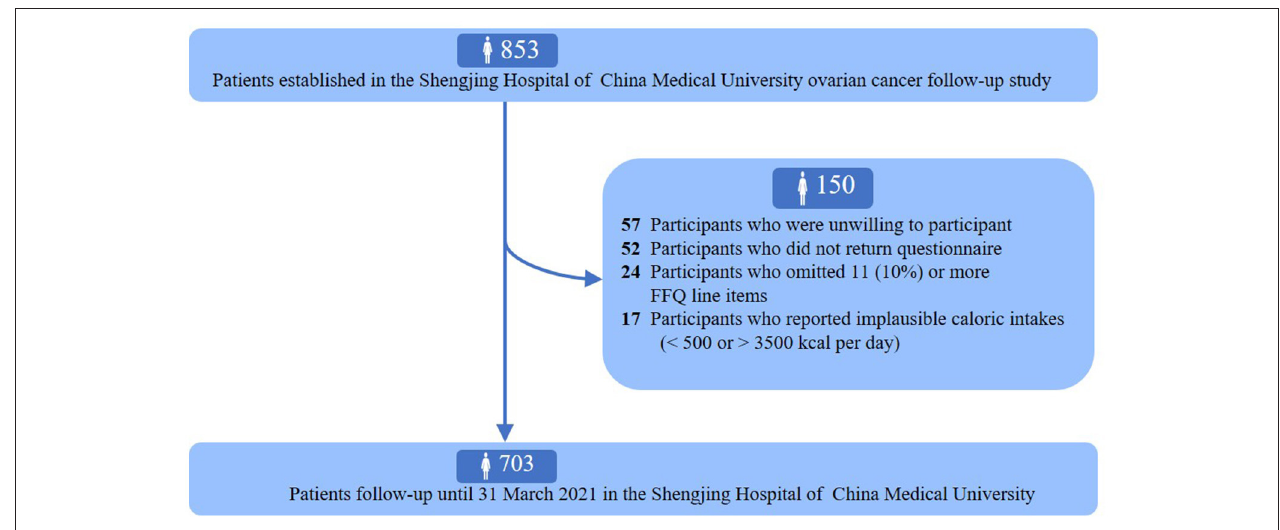
FIGURE 1 | Flow of participants through